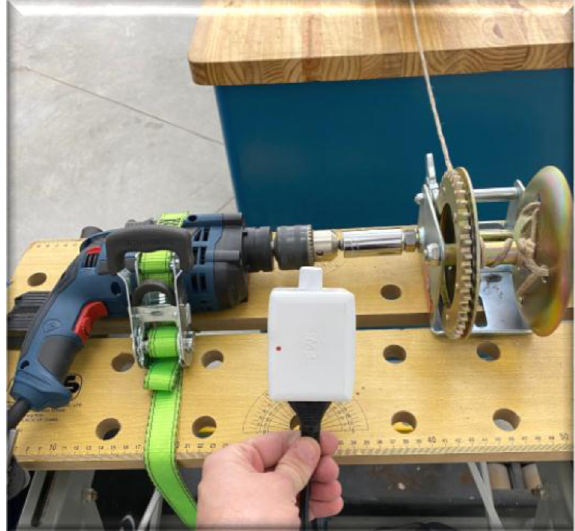
Fig. 7. Quadrant division.